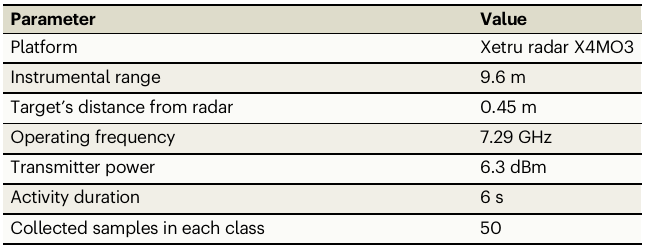
Table 1 | Con fi guration parameters of radar software